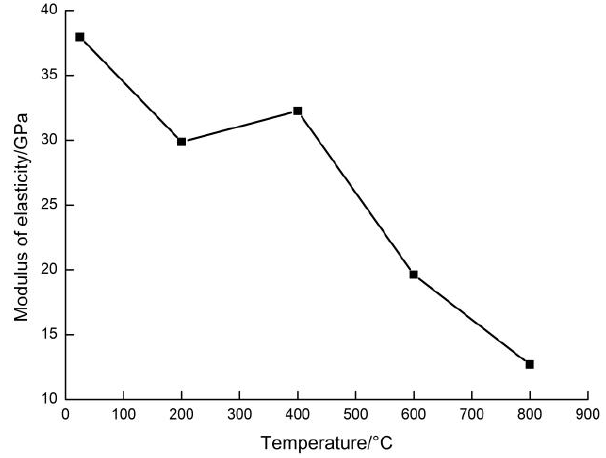
Figure 6. Modulus of elasticity of sandstone as a function of temperature.